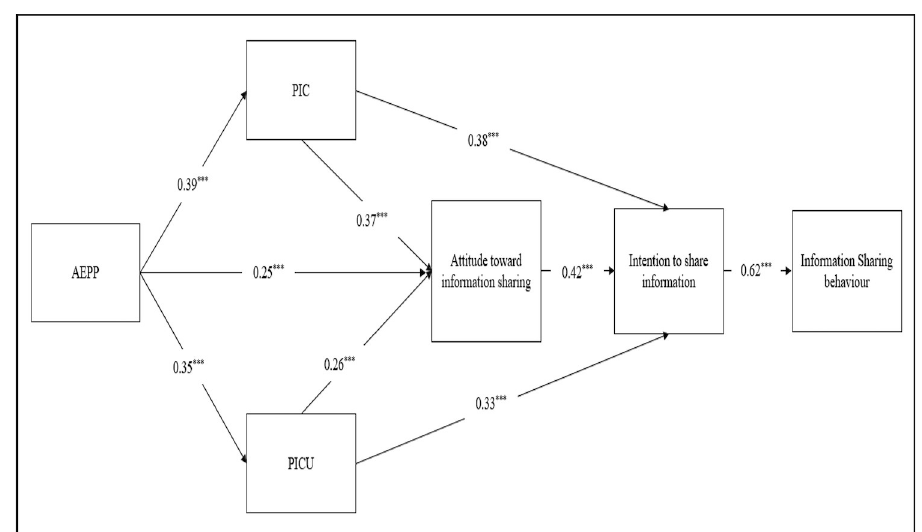
Fig 2. Results of structural model evaluation using the whole sample. ��� p < 0.01.